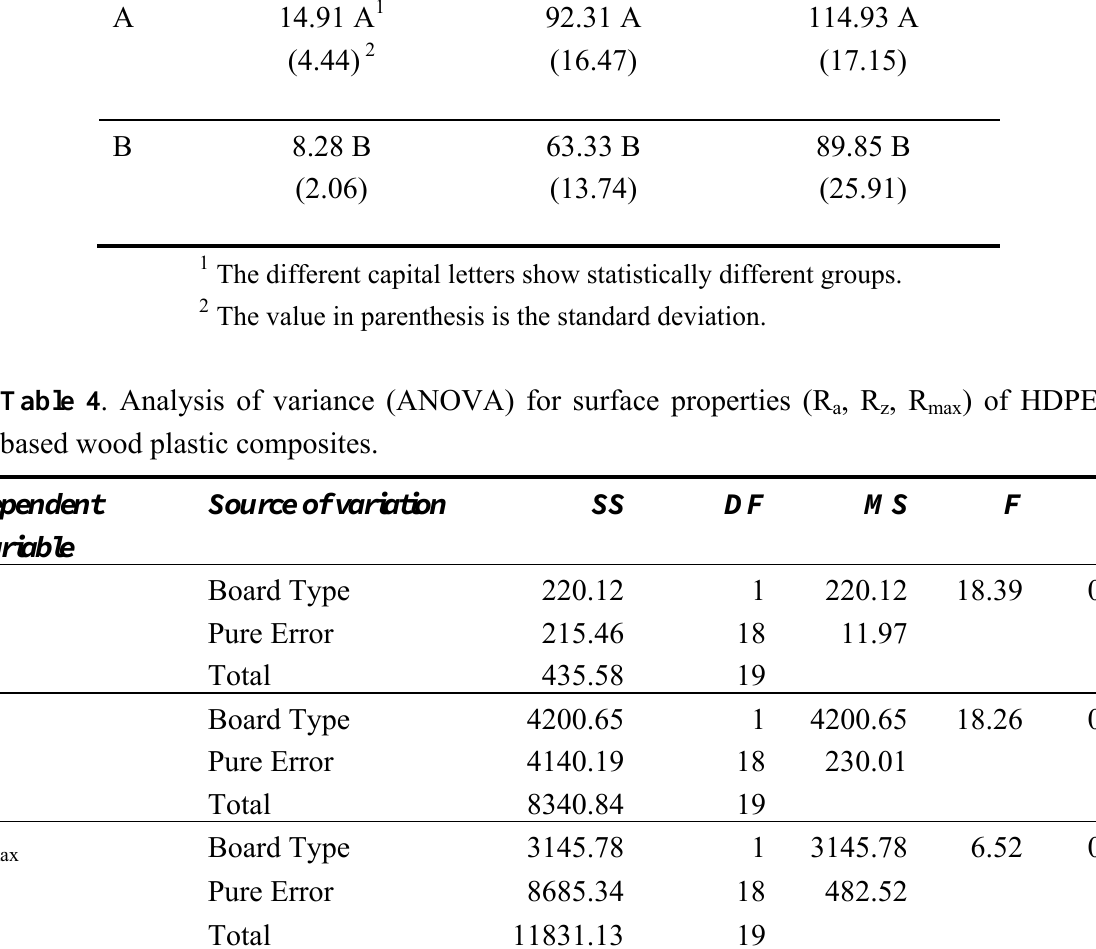
Table 3 . Surface roughness of the produced HDPE based wood plastic composites.